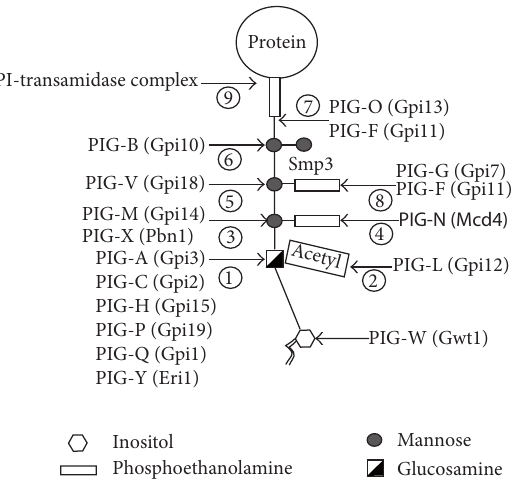
Figure 3: The GPI anchorage pathway. GPIs are glycolopids that act as a membrane anchor for many cell surface proteins and are composed of an inositol molecule that is sequentially modified in the ER with a Man3Glc N glycan and phosphoethanolamine groups. Numbers show sequential steps for the synthesis of a Man3Glc N glycan bearing GPI. A GPI-transamidase complex acts upon the phosphoethanolamine group linked to the terminal mannose to add the surface protein. The C. albicans Smp3 adds a fourth mannose residue that is essential for protein transfer; but in humans it is not essential for transamidation and its expression appears to be restricted to brain and